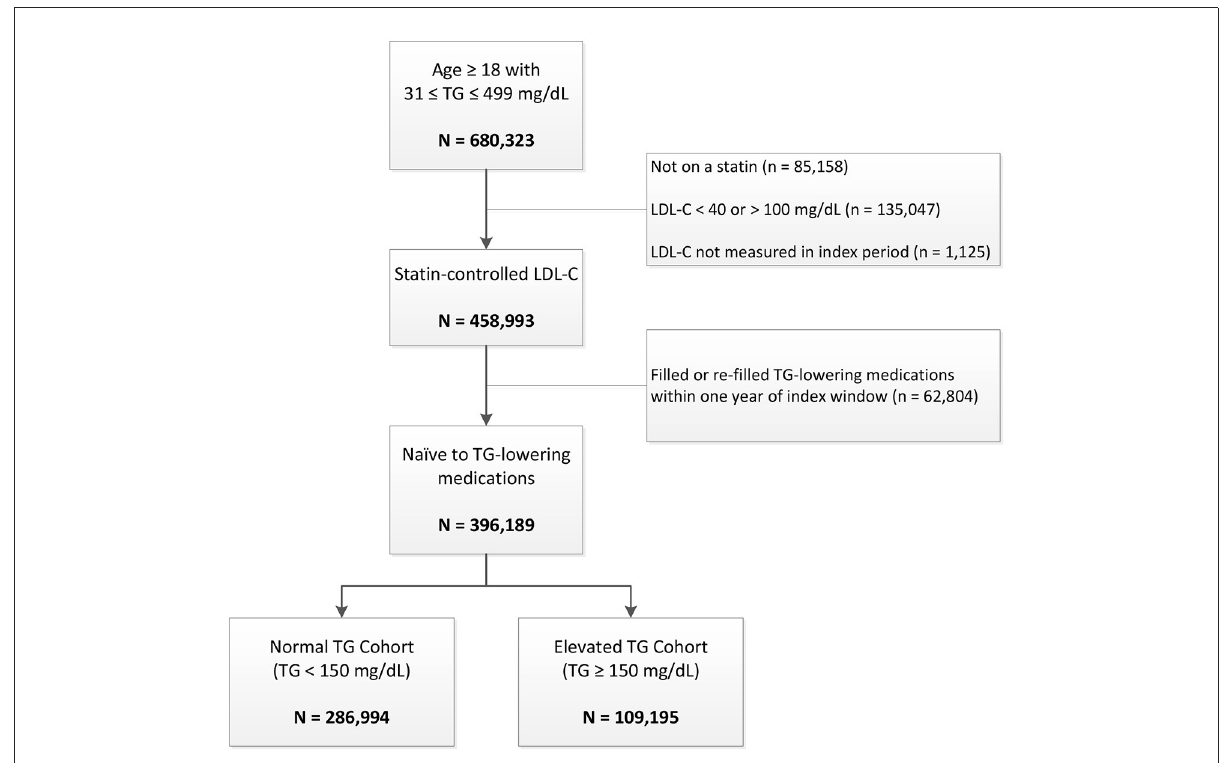
FIGURE1 Patient disposition. LDL-C indicates low-density lipoprotein cholesterol; TG,